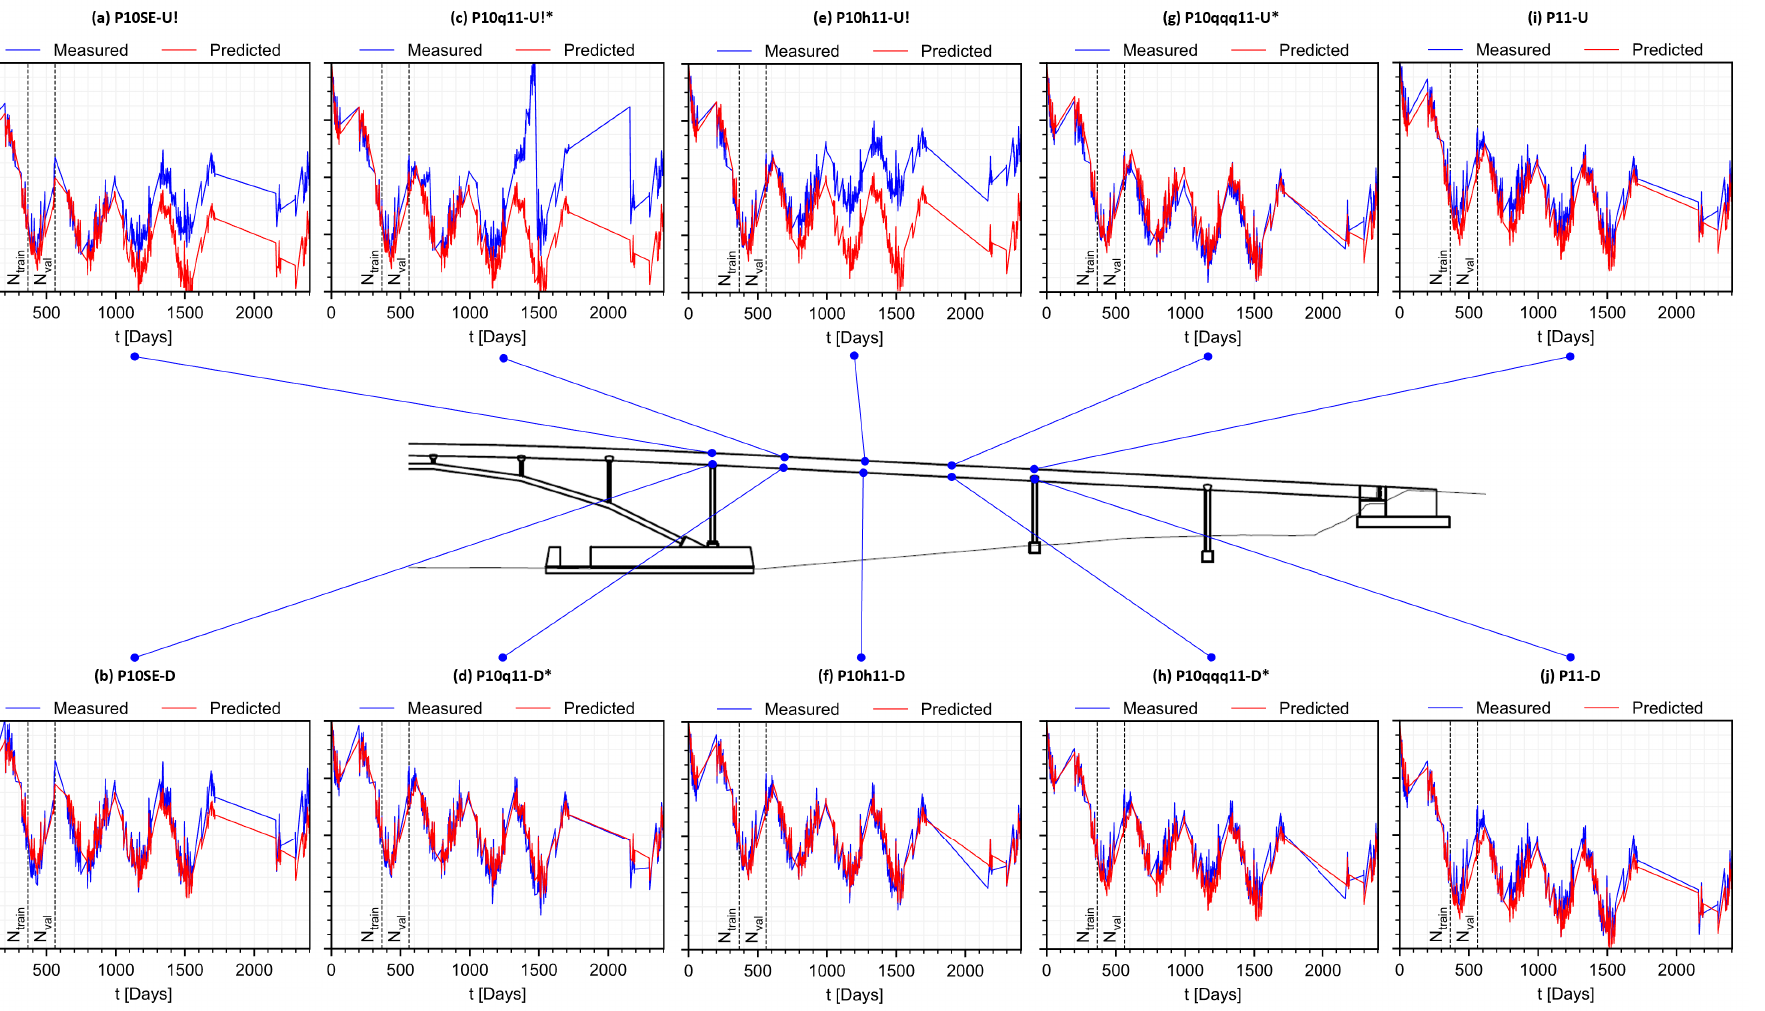
Figure 11. Predicted normal total strain at instrumented positions. Exclamation indicates positions with data anomaly. Asterisk indicates positions not observed during training or